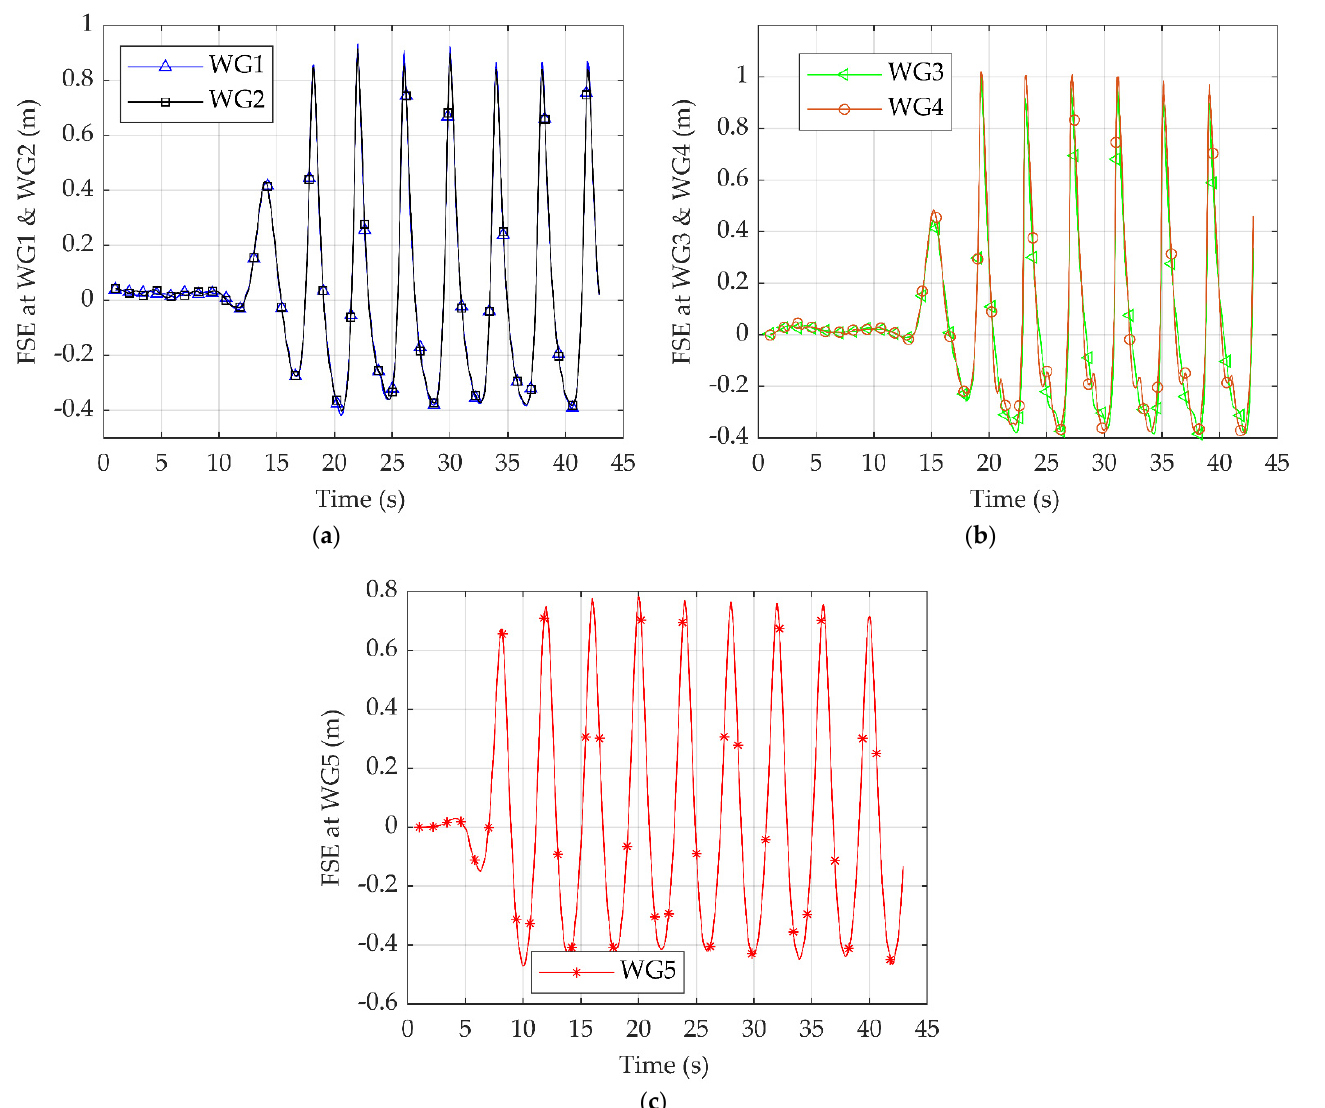
Figure 5. Free surface elevation at wave gauges for: ( a ) Wave Gauge 1 (WG1), WG2 ( b ) WG3, WG4, and ( c ) WG5.